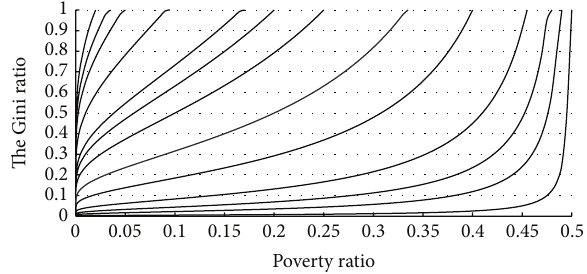
Figure 1: Relationship between Gini coefficient and poverty